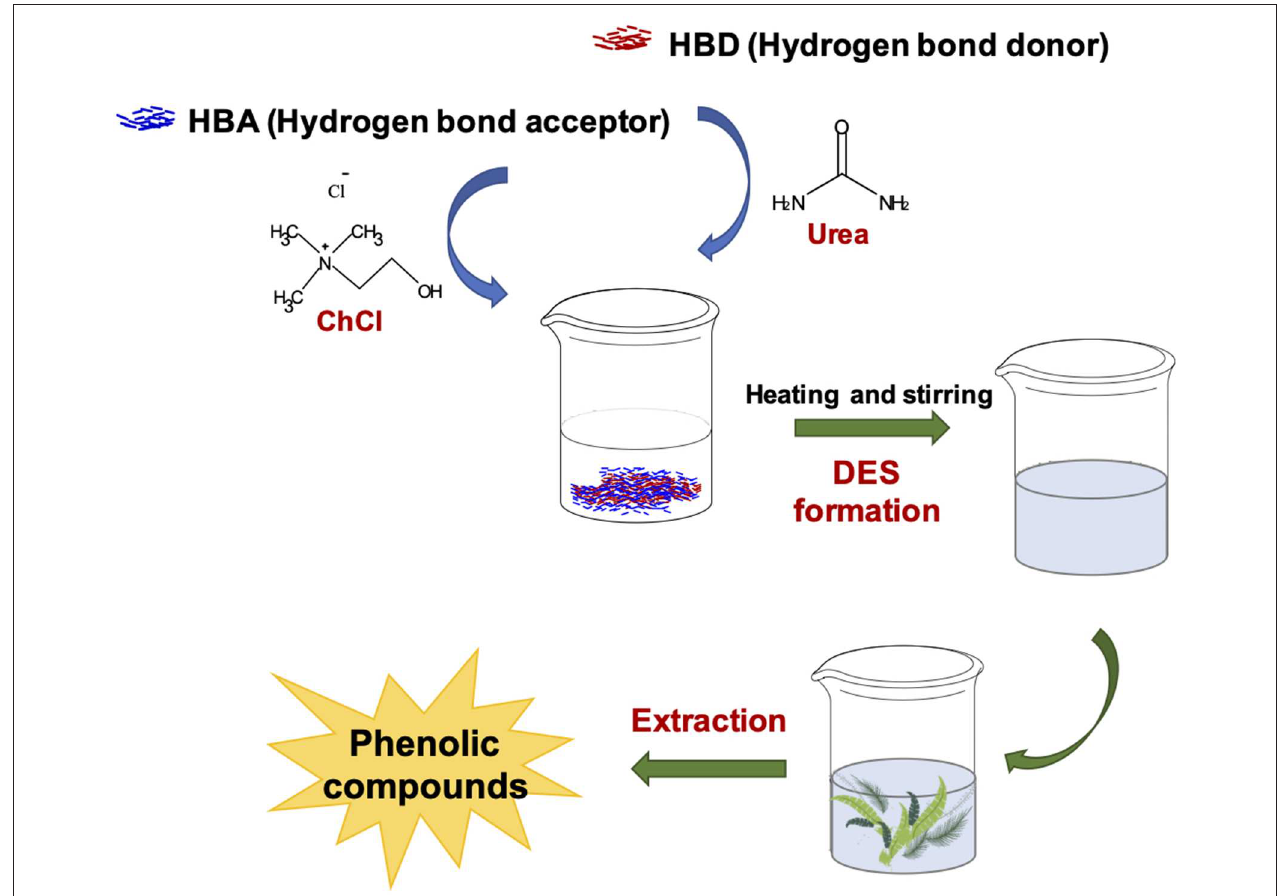
FIGURE 6 | Schematic representation of extraction of phenolic compounds with